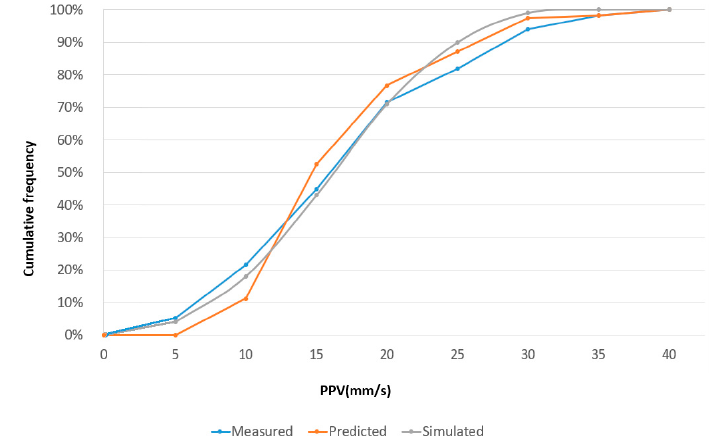
Figure 8. Measured PPV values together with their correspond predicted and simulated values.